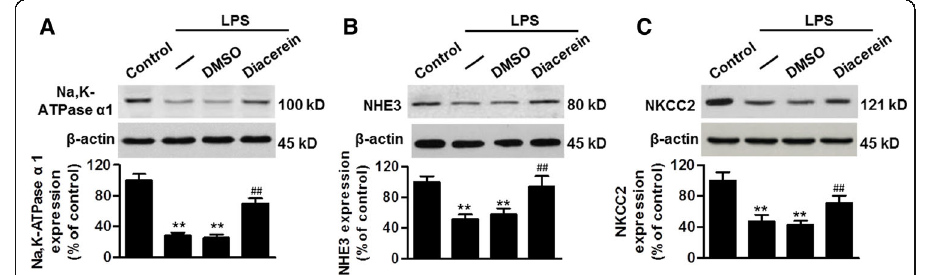
Fig. 5 Diacerein prevented downregulation of renal sodium transporter expression in endotoxemic mice. a - c Western blotting analysis of Na,K-ATPase α 1 ( a ), apical type 3 Na/H exchanger (NHE3) ( b ) and Na-K-2Cl cotransporter (NKCC2) ( c ) in renal tissues of each group. Downregulation of renal sodium transporter expression in endotoxemic mice was markedly reversed by diacerein treatment. ** P <0.01 vs. control, ## P <0.01 vs. LPS, n =6 in each